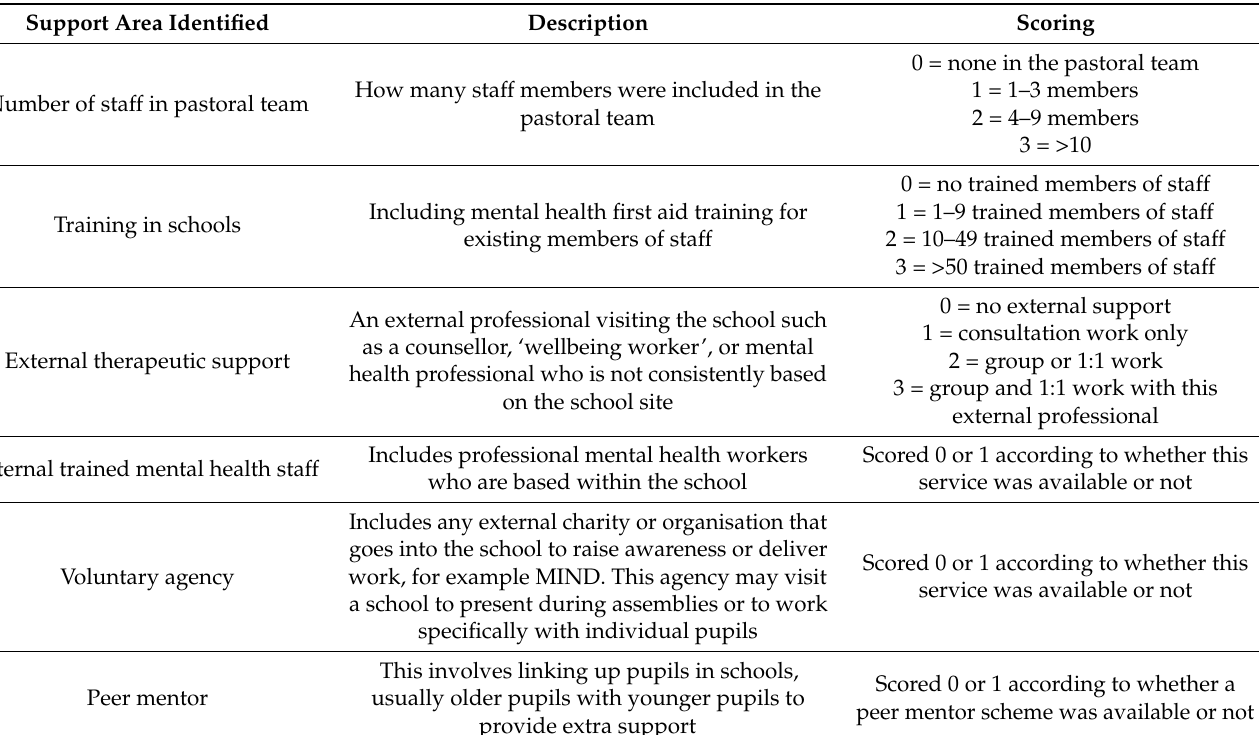
Table 1. Six common support areas for school